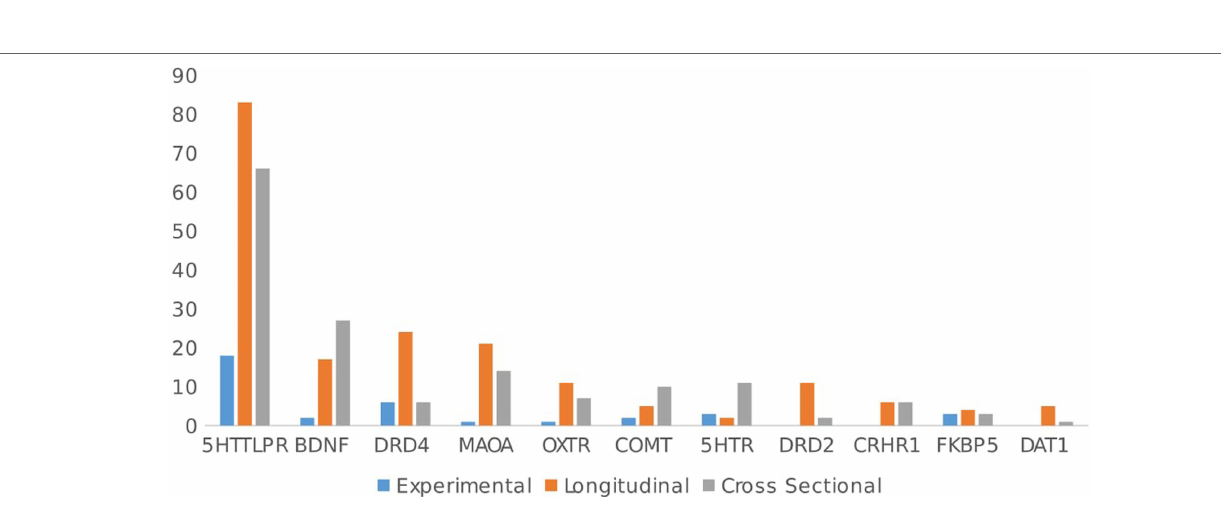
FiGURe 9 | Change in the number of studies of different type (cross-sectional or longitudinal) over time. There is a tendency to increase longitudinal over cross- sectional studies designs over time, but it is not significant ( z score = 0.64,